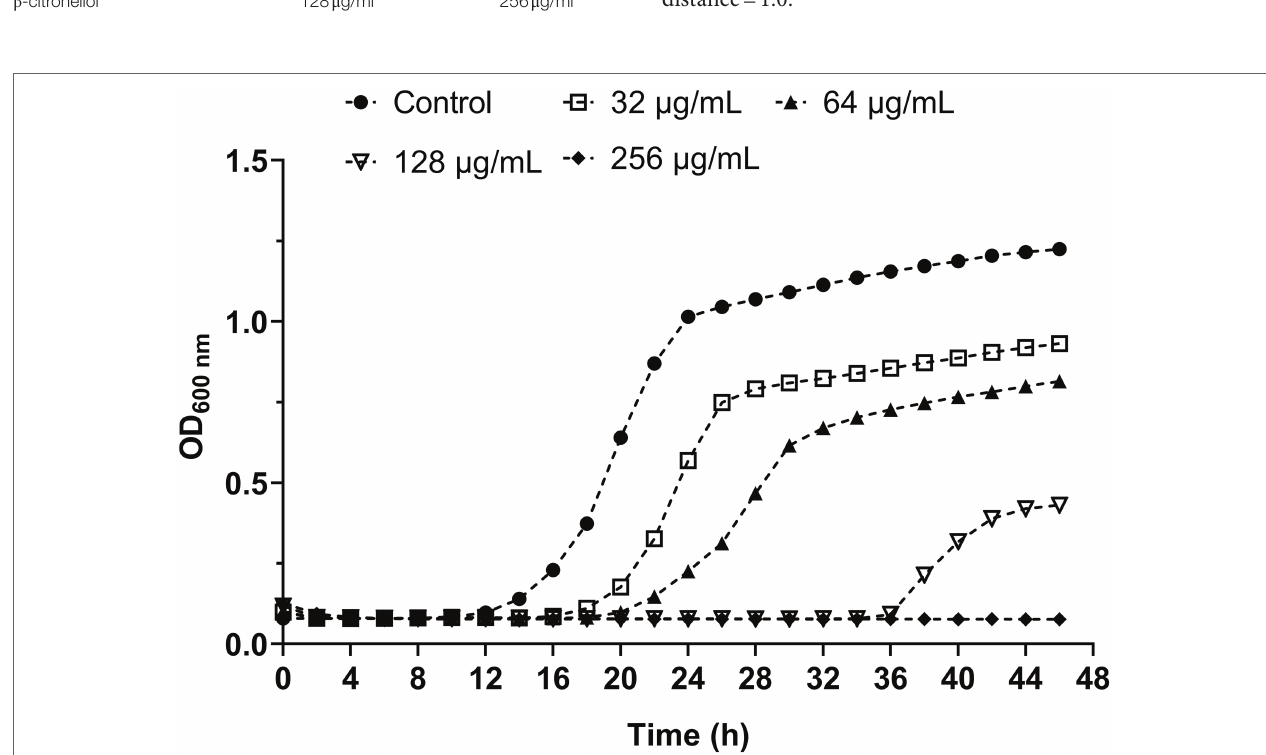
FIGURE 1 | Effect of β -citronellol on Candida albicans kinetic growth curve. Candida albicans (1 × 10 3 cells/ml) was treated with and without different concentrations of β -citronellol (32–256 μ g/ml) at 35 ± 2 ° C for 48 h. Cell culture in each condition was measured for absorbance at 600 nm every 2 h. All data are expressed as the mean of three